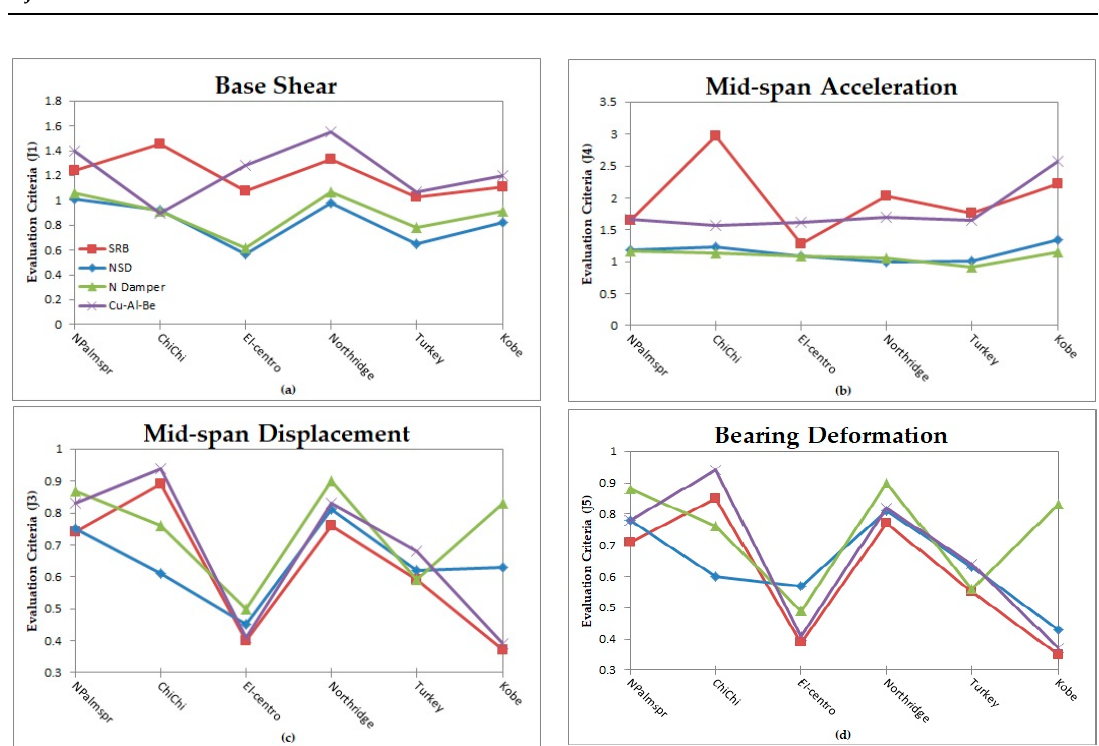
Figure 9. Comparison of ( a ) base shear, ( b ) mid-span acceleration, ( c ) mid-span displacement, and ( d ) bearing deformation for four passive control systems.